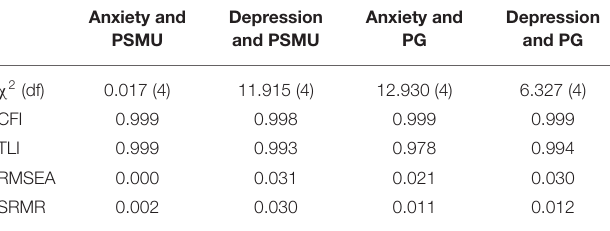
TABLE 4 | Fit indices of the random intercept cross-lagged models. Anxiety and Depression Anxiety and PSMU and PSMU